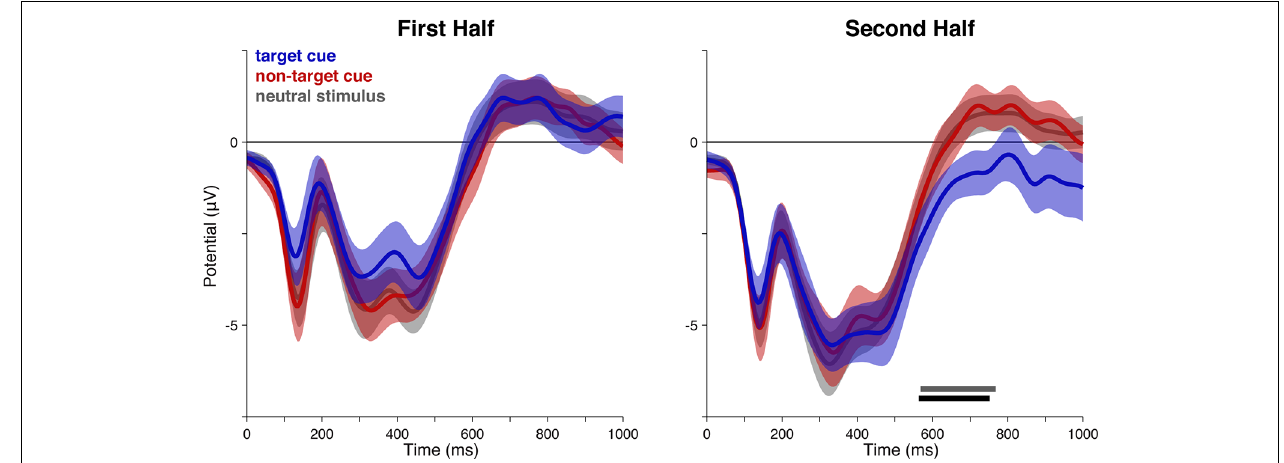
FIGURE 5 | Event-related potentials to target cues and control cues at frontal sensors in the first and second half of the experiment. Conventions are the same as Figure 3 . Horizontal bars indicate significant